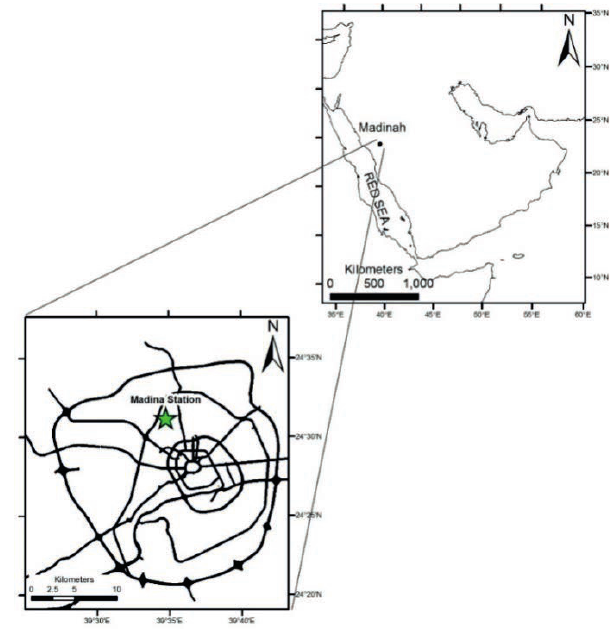
Fig. 1 The study